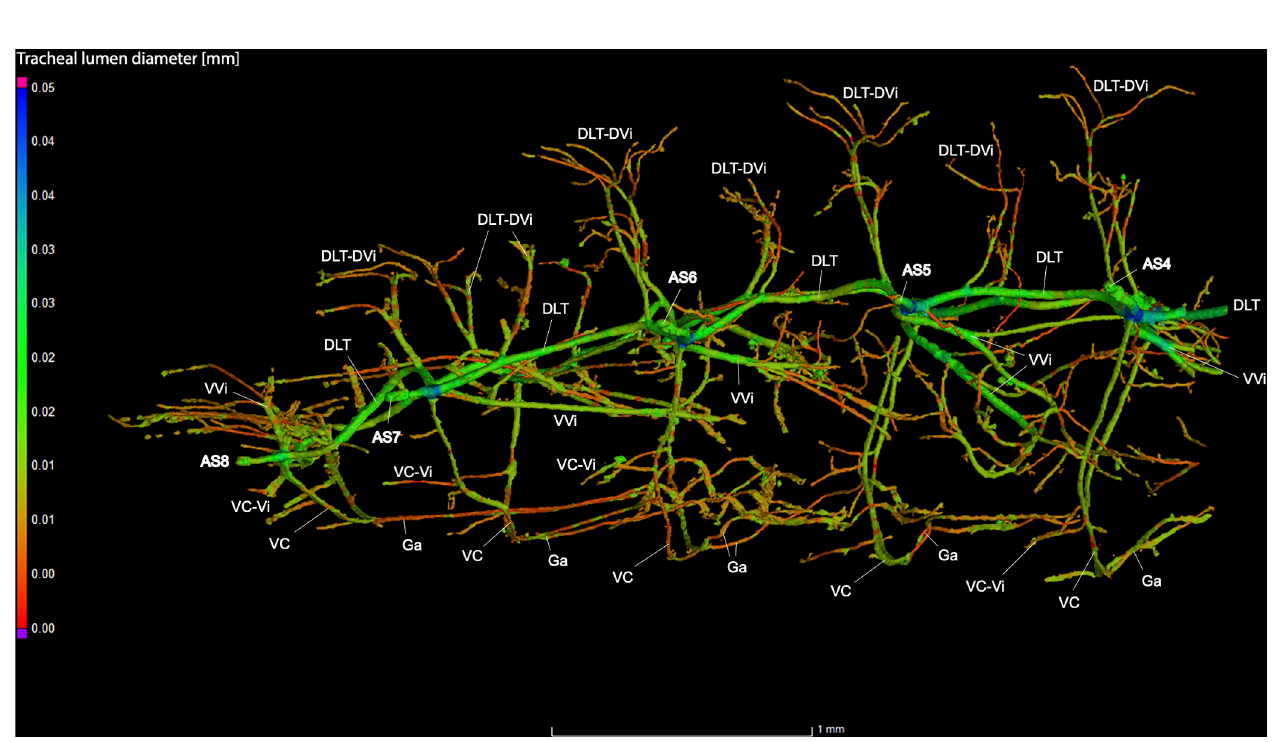
Fig 6. Lateral view of the abdominal tracheal system in Photinus pyralis 3–4 day-old pupa.